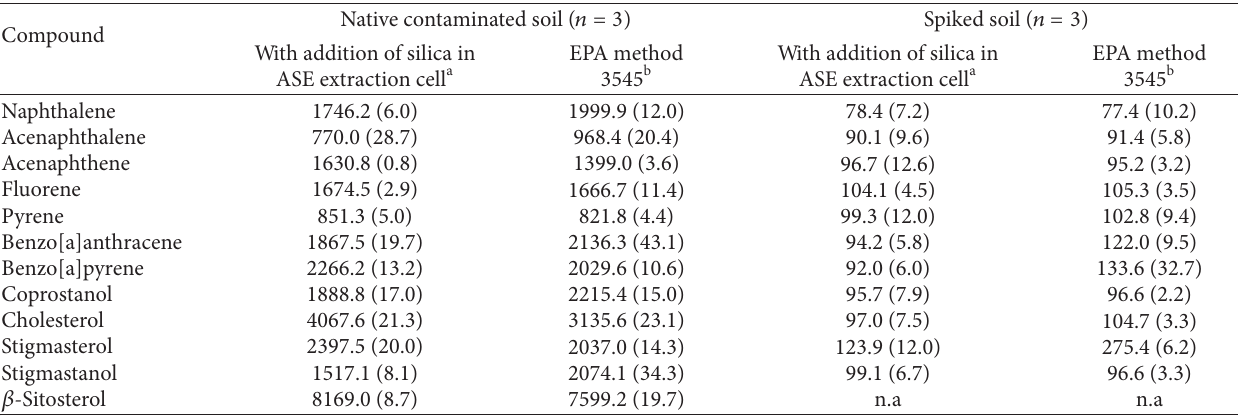
T 5: Amount of PAHs and sterols ( ) of PAHs and sterols from